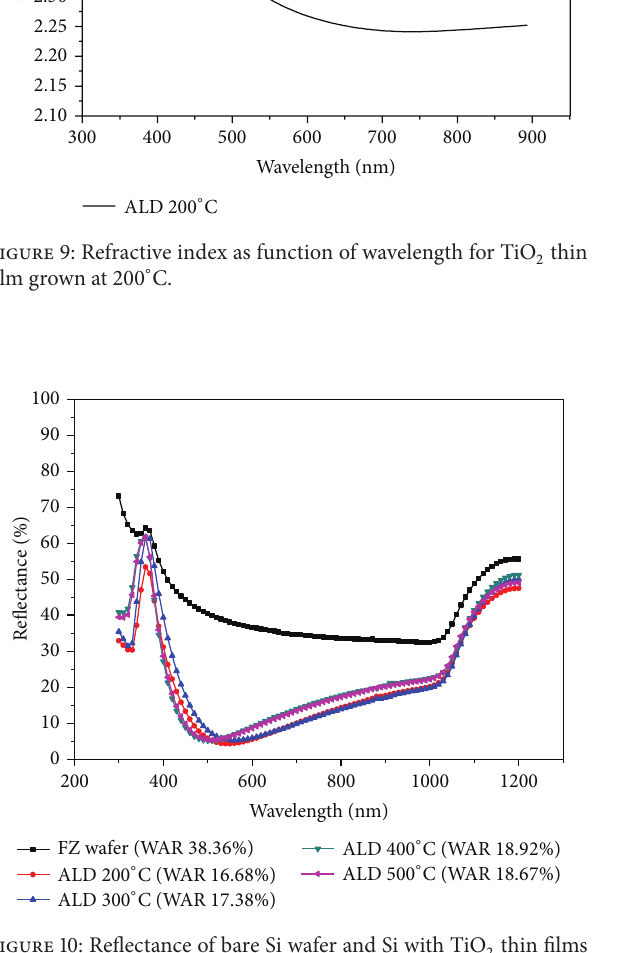
Figure 10: Reflectance of bare Si wafer and Si with TiO 2 thin films grown at different temperatures as function of wavelength from 300 nm to